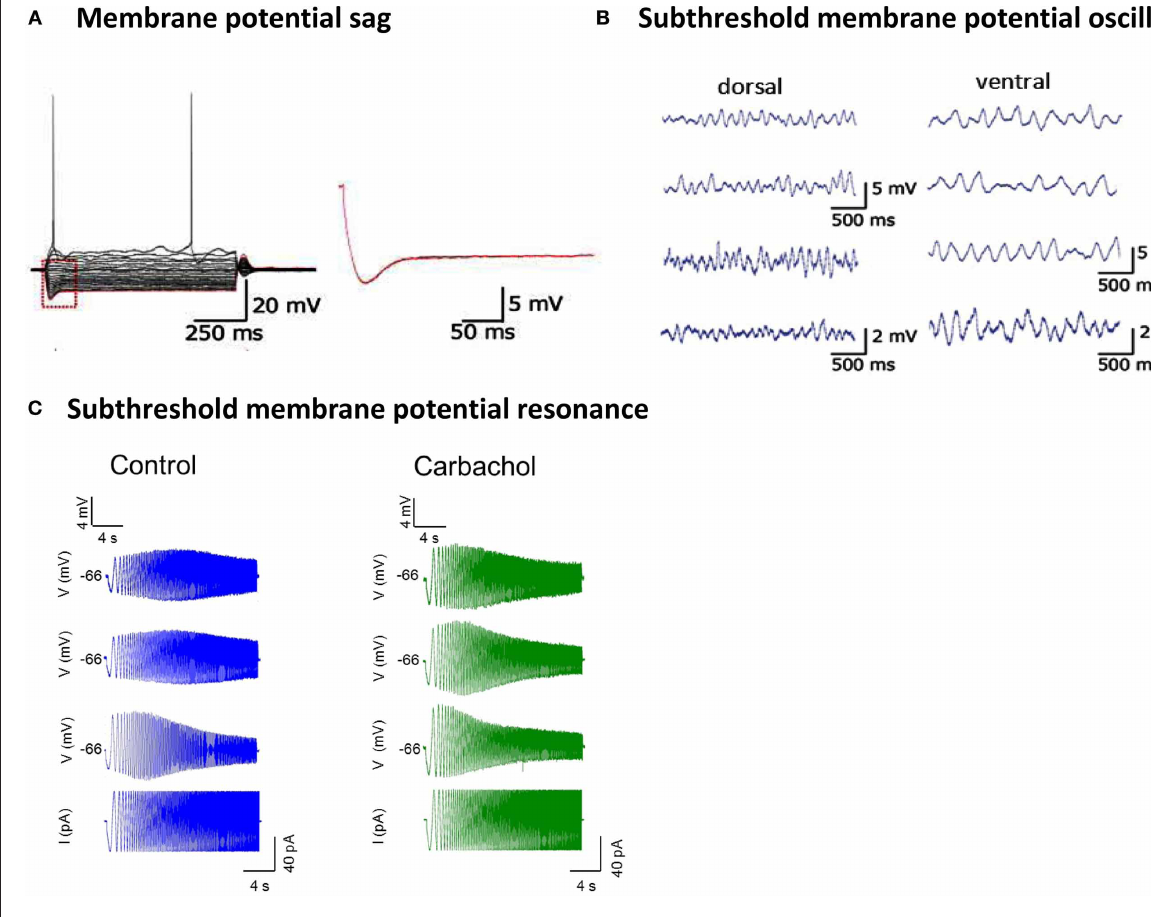
membrane potentials of − 50mV (top) and − 45mV (bottom). (C) Subthreshold membrane potential resonance characterized in current clamp recordings of three different stellate cells. The membrane potential (top three traces) is shown response to the sinusoidal current injection (bottom trace). The subthreshold membrane resonance is measured in control (blue) and after application of carbachol (green). ( Figures 2A and 2B reprinted with permission from Giocomo et al., 2007. Figure 2C reprinted with permission from Heys et al., 2010).